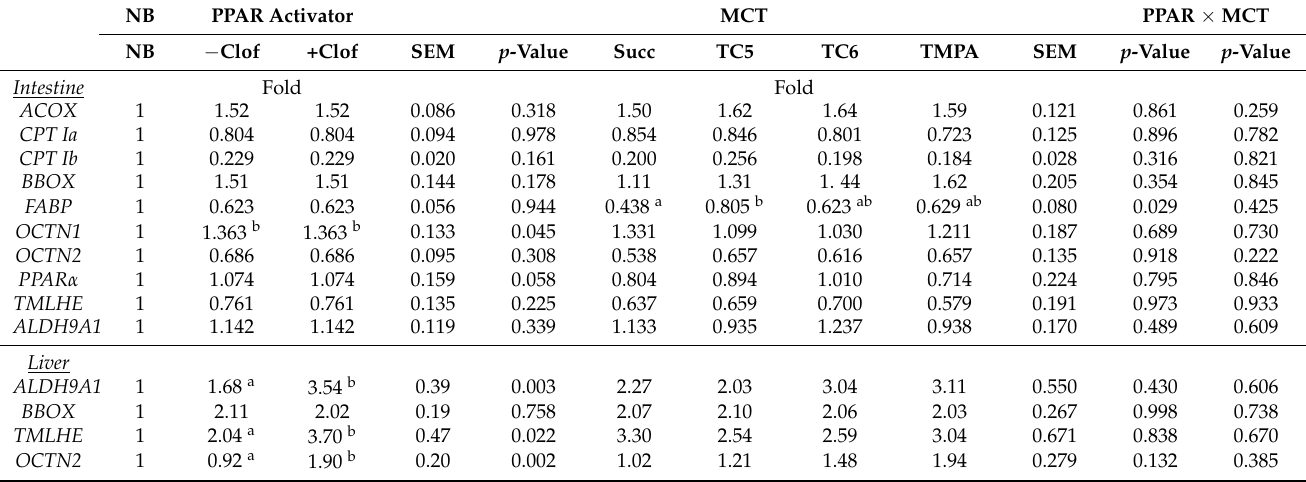
Table 6. Gene expression measured in intestines and